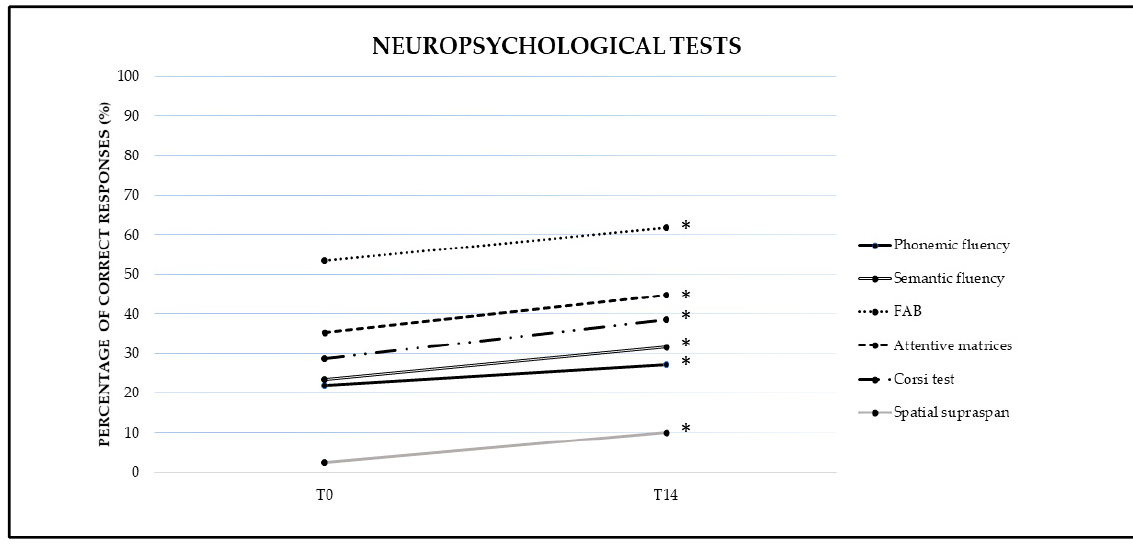
Figure 3. Mean percentage of correct responses for each neuropsychological test at baseline (T0) and at the end of the treatment (T14). Sig. mixed ANOVA design: * p ≤ 0.05.